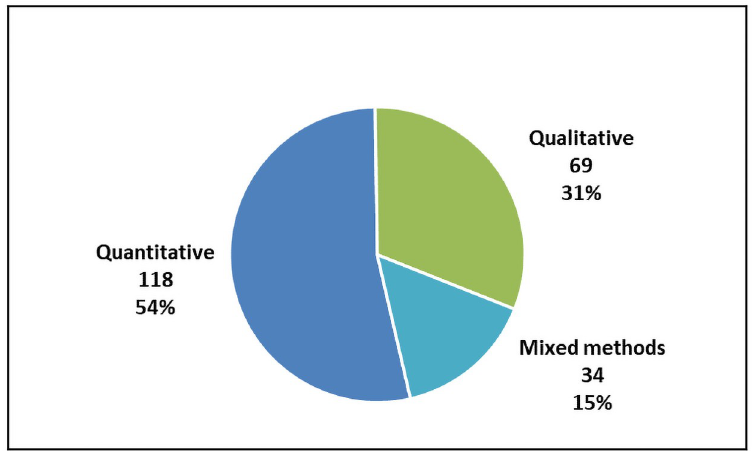
Fig 2. Number of articles by research method.